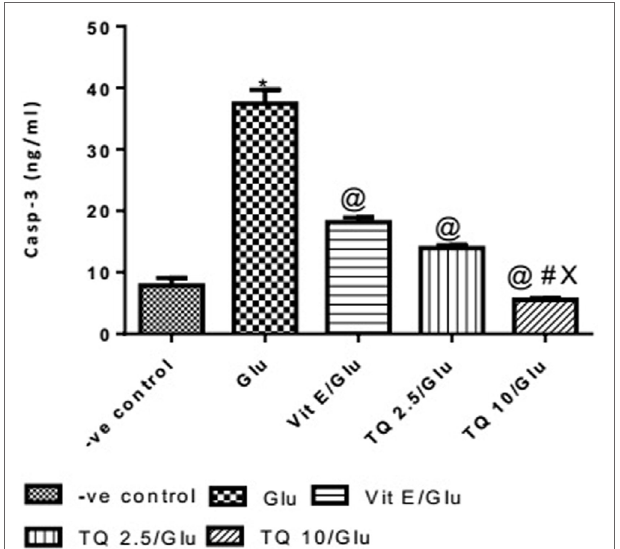
FigUre 3 | Effect of Glu, Vit E/Glu, TQ2.5/Glu, and TQ10/Glu on mean escape latency in the Morris water maze test. Glu was injected i.p. as a single dose for 7 days. TQ and Vit E were injected as a single dose for 7 days. Each value represents the mean value of 12 rats ± SEM. Statistics were carried out by one-way ANOVA followed by Tukey’s multiple comparison tests, by graph pad prism 5. *Statistically significant from − ve control group ( p < 0.05); @ statistically significant from Glu group ( p < 0.05); # statistically significant from Vit E/Glu group ( p < 0.05); X statistically significant from TQ 2.5/Glu group ( p < 0.05).